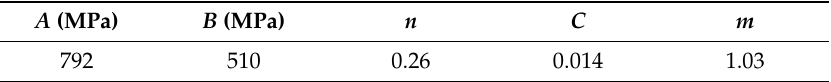
Table 5. Johnson-Cook parameters of the rail material.